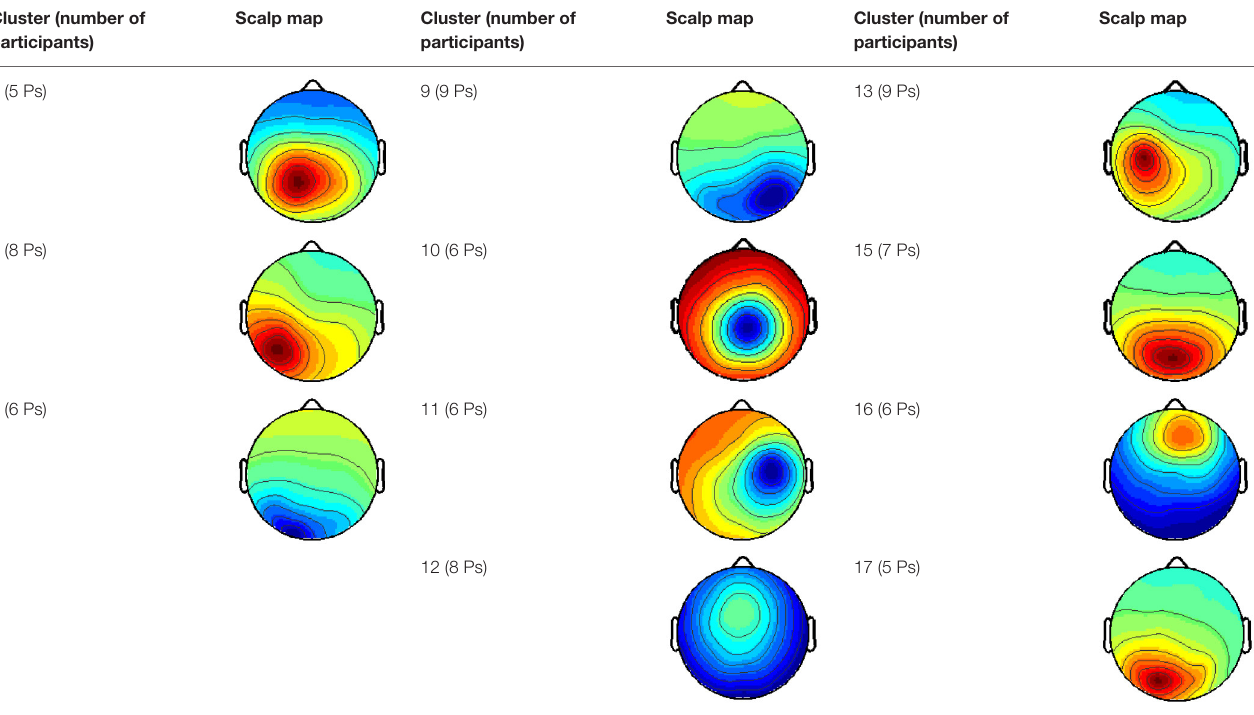
Scalp map Cluster (number of participants)